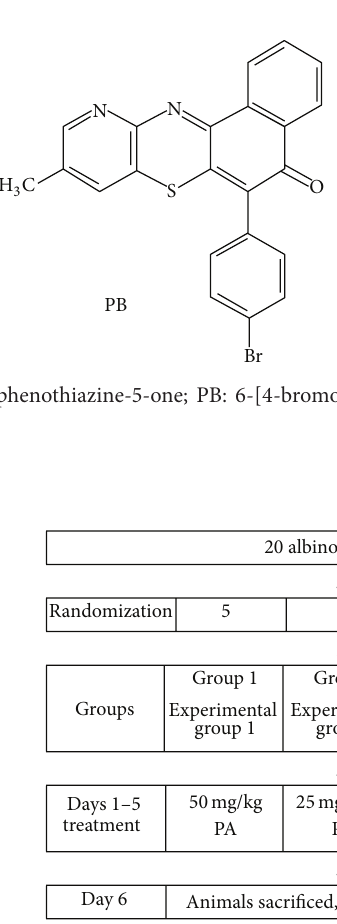
Figure 2: Experimental design chart. PA: